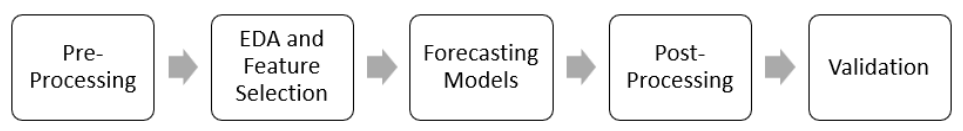
Figure 1. Methodology